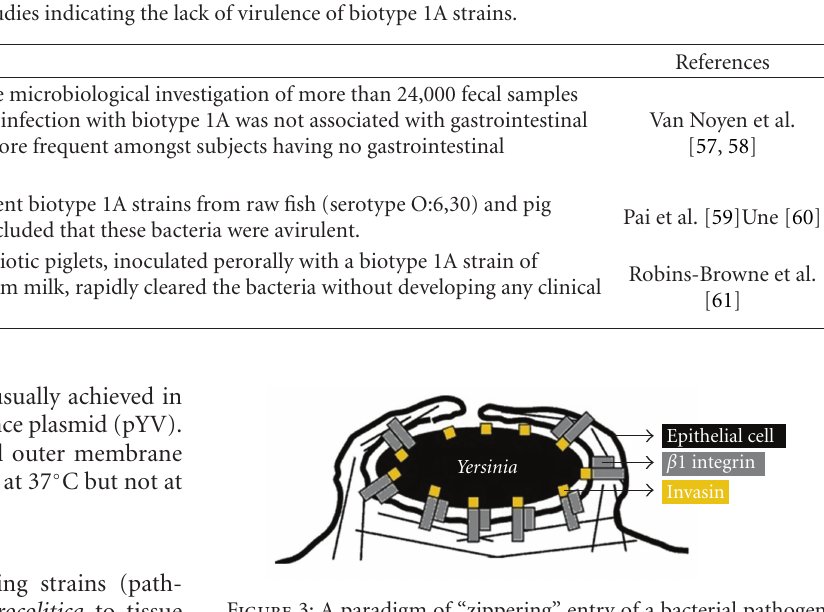
Figure 3: A paradigm of “zippering” entry of a bacterial pathogen into epithelial cells. Invasin mediated binding of Yersinia to β 1 integrins and internalization (adapted from